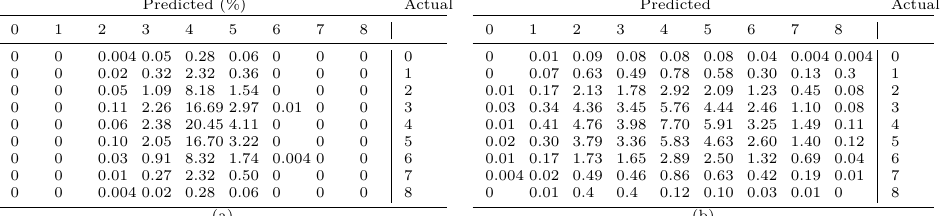
Table 4: Confusion matrix for the AES_HD (a) imbalanced dataset, (b) after SMOTE, RF with 1 000 iterations, 10 000 measurements in the training phase (plus the measurements obtained with SMOTE in latter) and 25 000 measurements in the testing phase. Results are given in percentages. Predicted